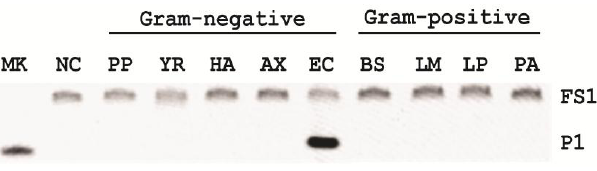
Figure 5. Specificity of EC1T/FS1 for various gram-negative and gram-positive bacteria. PP: Pseudomonas peli , YR: Yersinia rukeri , HA: Hafnea alvei , AX: Achromobacter xylosoxidans , EC: Escherichia coli , BS: Bacillus subtilis , LM: Leuconostoc mesenteroides , LP: Lactobacillus planturum , PA: Pediococcus acidilactici .